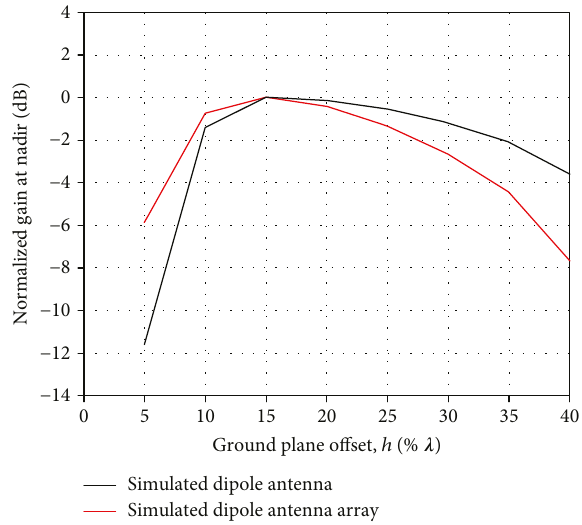
Figure 22: Comparing the ground plane o ff set versus normalized gain for the single dipole element and